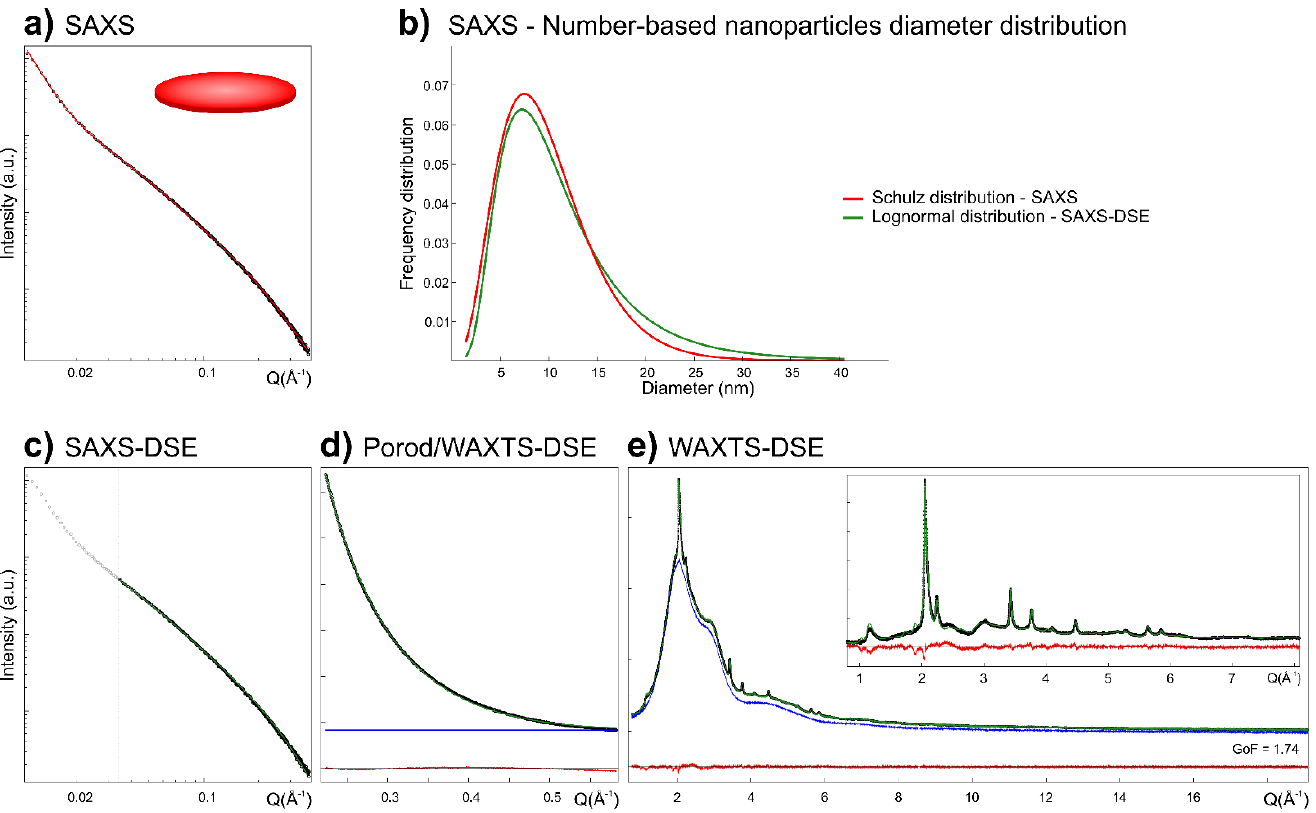
Figure 2. ( a ) SAXS data (black dots, log-log scale) of Me-S-H nanoparticles and best fit (solid red line) from analytical form factor using the disc-shaped model; ( b ) comparison between the number-based diameter size distributions obtained by conventional SAXS analysis using a Schulz distribution (red line) and by the DSE modeling approach using a lognormal distribution (green line); ( c ) SAXS data (black dots, log-log scale) and ( d , e ) synchrotron WAXTS data (black dots) of Me-S-H nanoparticles. In ( c – e ), the solid green line is the best fit obtained through the DSE using the single-layer atomistic model. The WAXTS pattern of the dispersing solution (blue trace) was added as a model component and scaled to the experimental data. The red line is the residual between experimental and calculated patterns. The inset reports the WAXTS pattern and the DSE fit in a limited Q range by subtracting the scattering contribution of the solution.